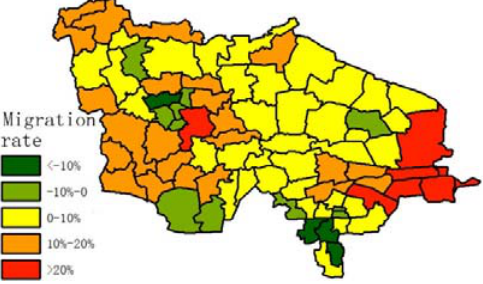
Figure 10. Average birth rate of each town from 2011 to 2015.